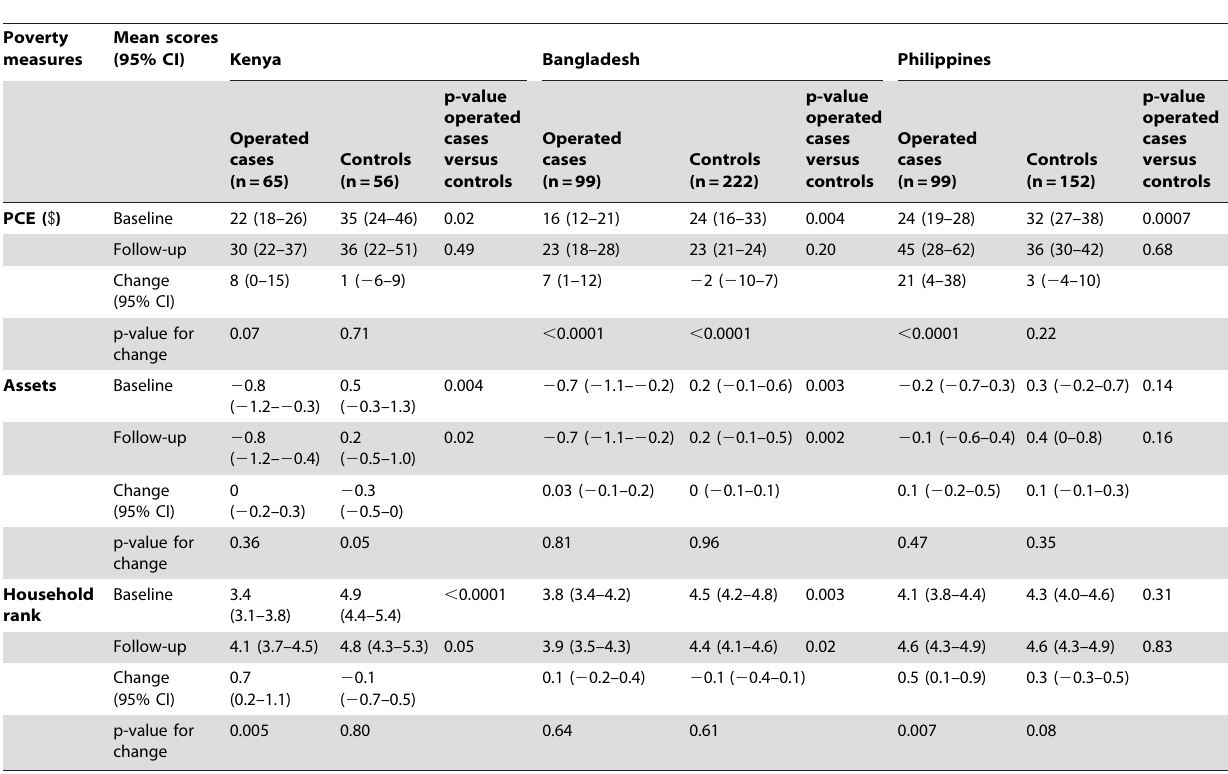
Table 3. Comparison of PCE, assets and household rank at baseline and follow up for operated cases and controls. Poverty